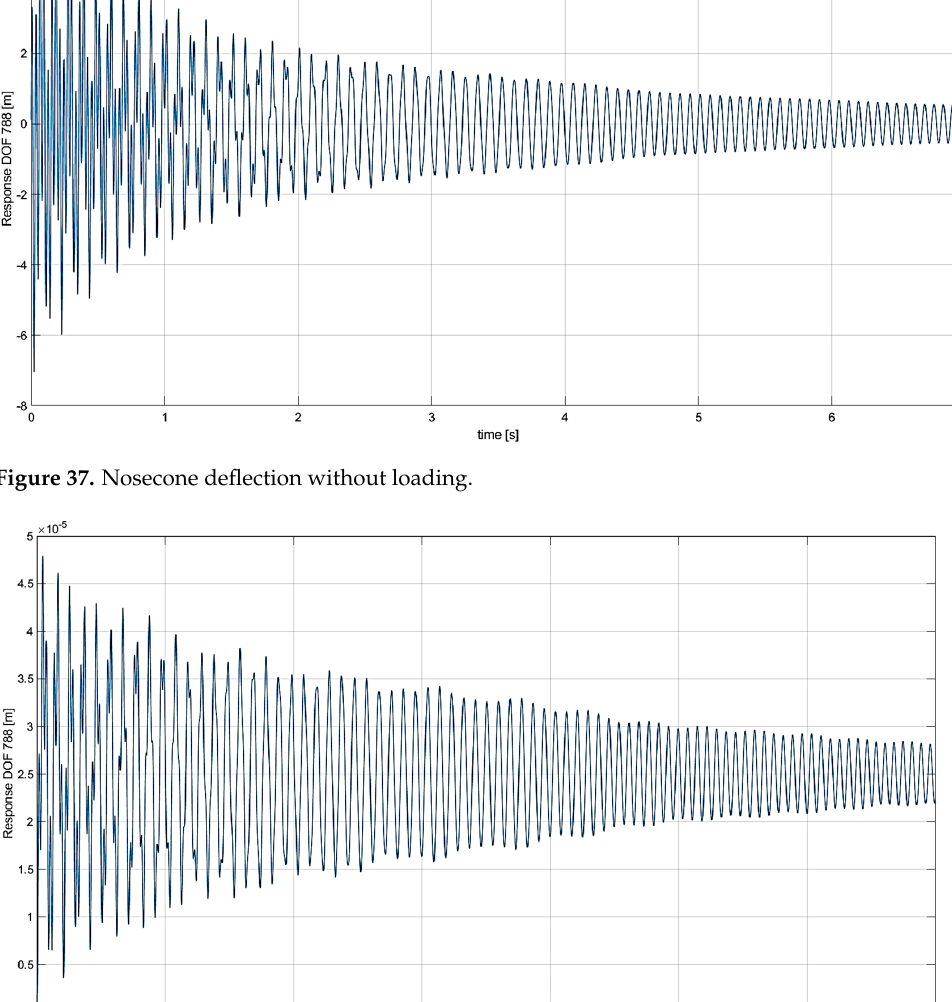
Figure 38. Deflection of nosecone under Mach 0.5 and pre-stress load.